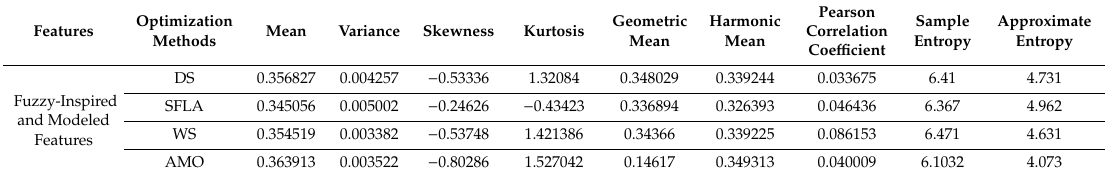
Table 8. Average parameters at various optimization techniques with di ff erent features for CVD cases.